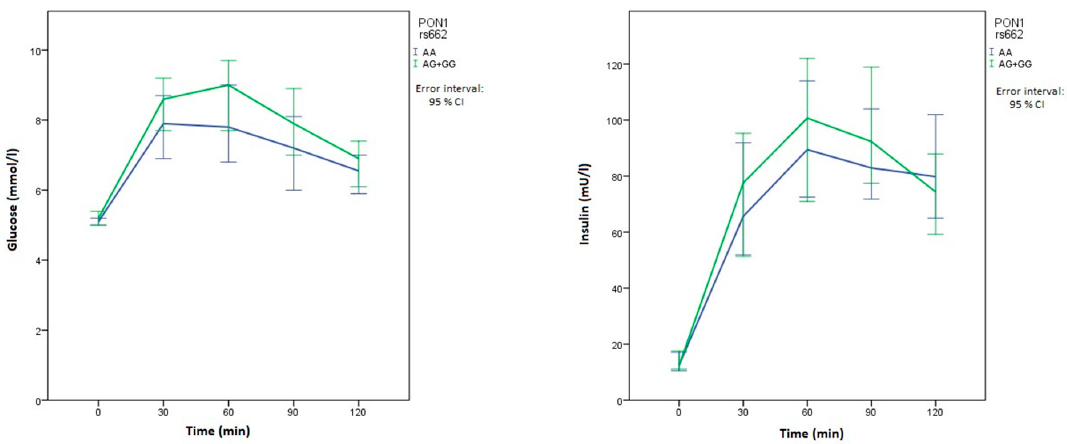
Figure 2. Time course of glucose and insulin levels for PON1 rs662. The blue line represents the reference genotype, while the green line represents patients with at least one polymorphic allele.